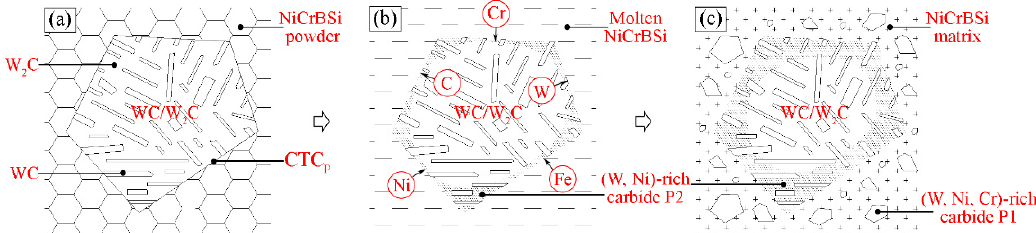
Figure 6. Dissolution schematic diagram of the unmodified CTC P in NiCrBSi alloy: ( a ) Before sintering; ( b ) Interdiffusion of elements and (W, Ni)-rich carbide forming; ( c ) (W, Ni, Cr)-rich carbide precipitating.